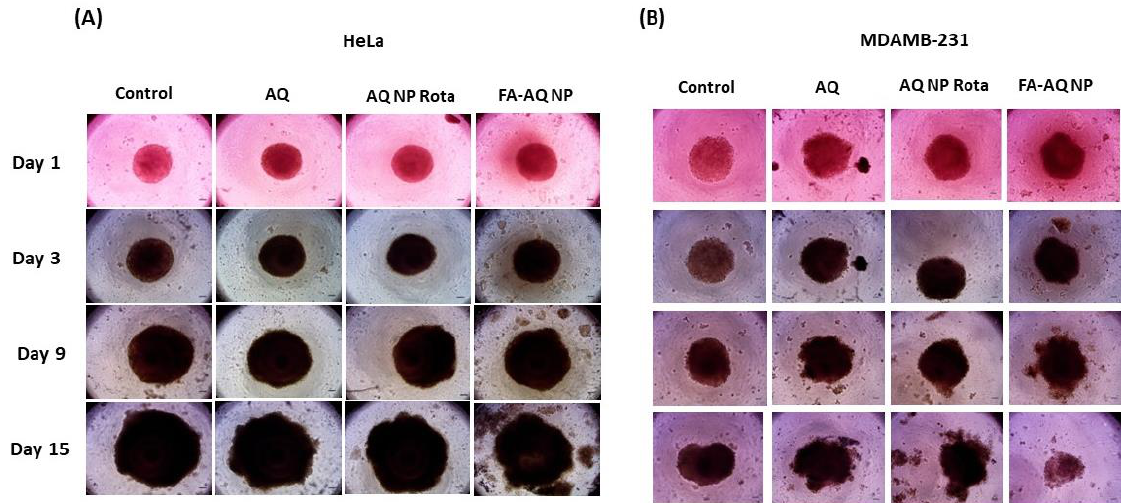
Figure 8. Three-dimensional spheroid study: ( A , B ) Spheroid images of HeLa ( A ) and MDAMB-231 ( B ) cell lines after treating with control, AQ, AQ NP Rota, and FA-AQ NP. Images represent n = 8 for each treatment. Images were captured using Evos-FL fluorescence microscope with 4X objective. Scale bar is 400 µm.